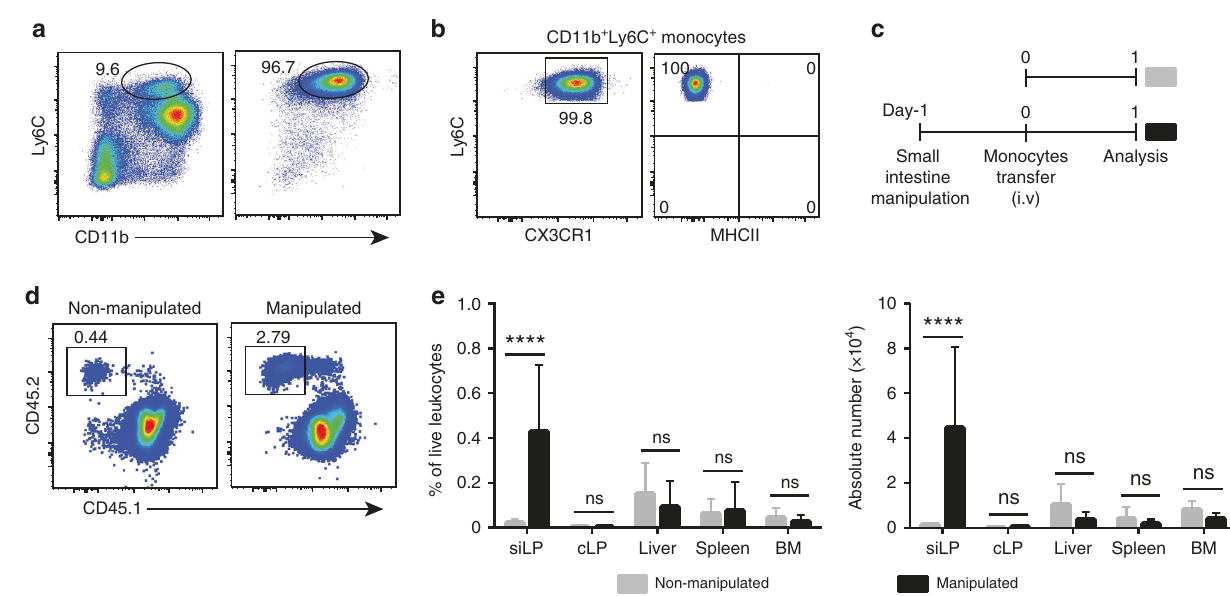
Fig. 1 Small intestinal in fl ammation increases the recruitment of adoptively transferred monocytes. a Representative FACS plots demonstrating frequencies of CD11b + Ly6C + monocytes among live leukocytes in bone marrow (BM) of CX3CR1 gfp/ + mice before (left panel) and after enrichment (right panel). b Expression of CX3CR1/GFP and MHCII on puri fi ed monocytes as indicated in a . c Schematic illustration of the experimental set-up for d , e . Monocytes were transferred into untreated recipients (non-manipulated mice) or one day after small intestinal manipulation (manipulated mice). d Frequencies of adoptively transferred CD45.2 + donor cells in small intestinal lamina propria (siLP) one day after transfer into non-manipulated and manipulated CD45.1 + CCR2-de fi cient recipients. FACS plots are gated on live CD11b + cells. e Frequencies and total numbers of CD64 + CD11b + Ly6C + donor monocytes recovered from siLP, colonic lamina propria (cLP), liver, spleen, and BM. Bar charts illustrate data pooled from at least three independent experiments with a total of at least fi ve mice each. Unpaired t -test; mean ± s.d.; ns not signi fi cant; **** p <